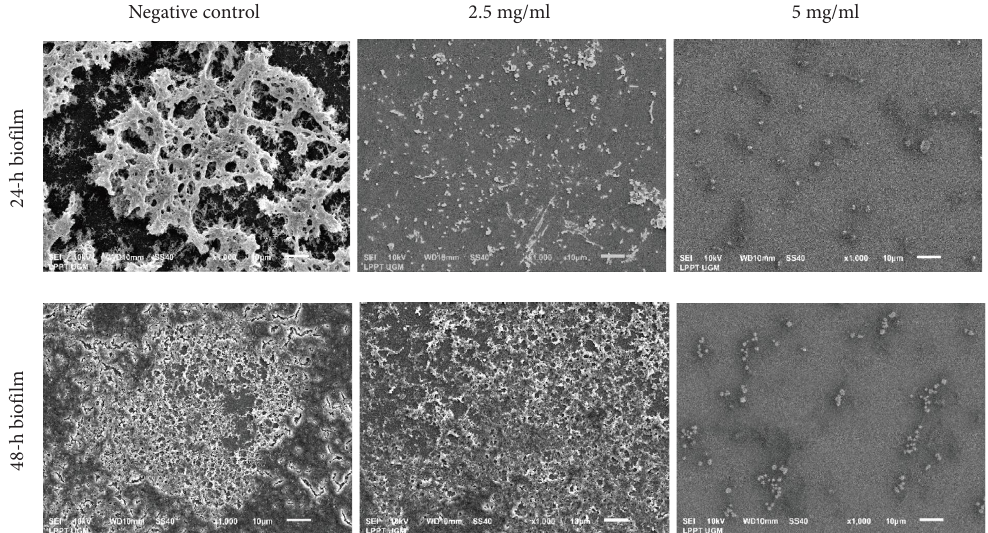
Figure 3: Representative SEM images showing reduction of S. mutans and S. sanguinis bioflm masses after exposure with varying concentrations of PSNC for 24 and 48 h. In untreated control groups, the bioflm is clearly visible with the bacteria embedded in EPS. Te bioflm masses become less after being exposed to PSNC for 24 and 48